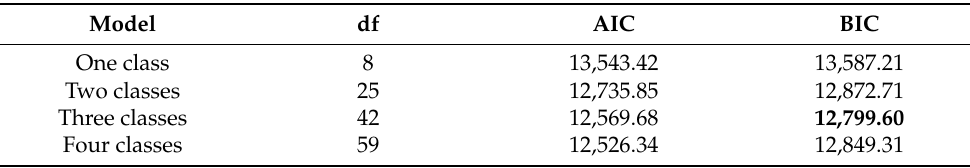
Table 1. Model fit to identify an optimal number of latent classes.